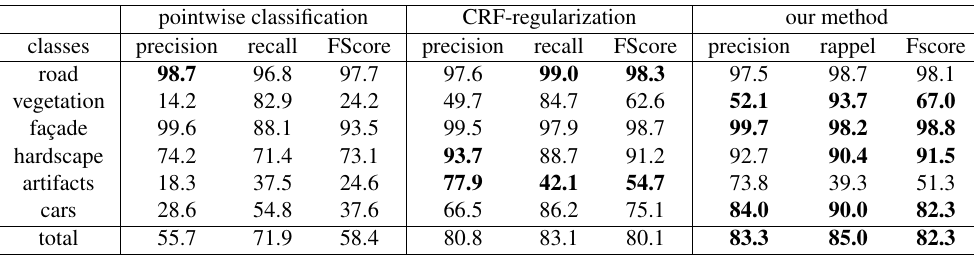
Table 2. Precision, recall and FScore in % for the Semantic3D benchmark. The global accuracy are respectively 88.4%, 96.9% et 97.2%. In bold, we represent the best value in each